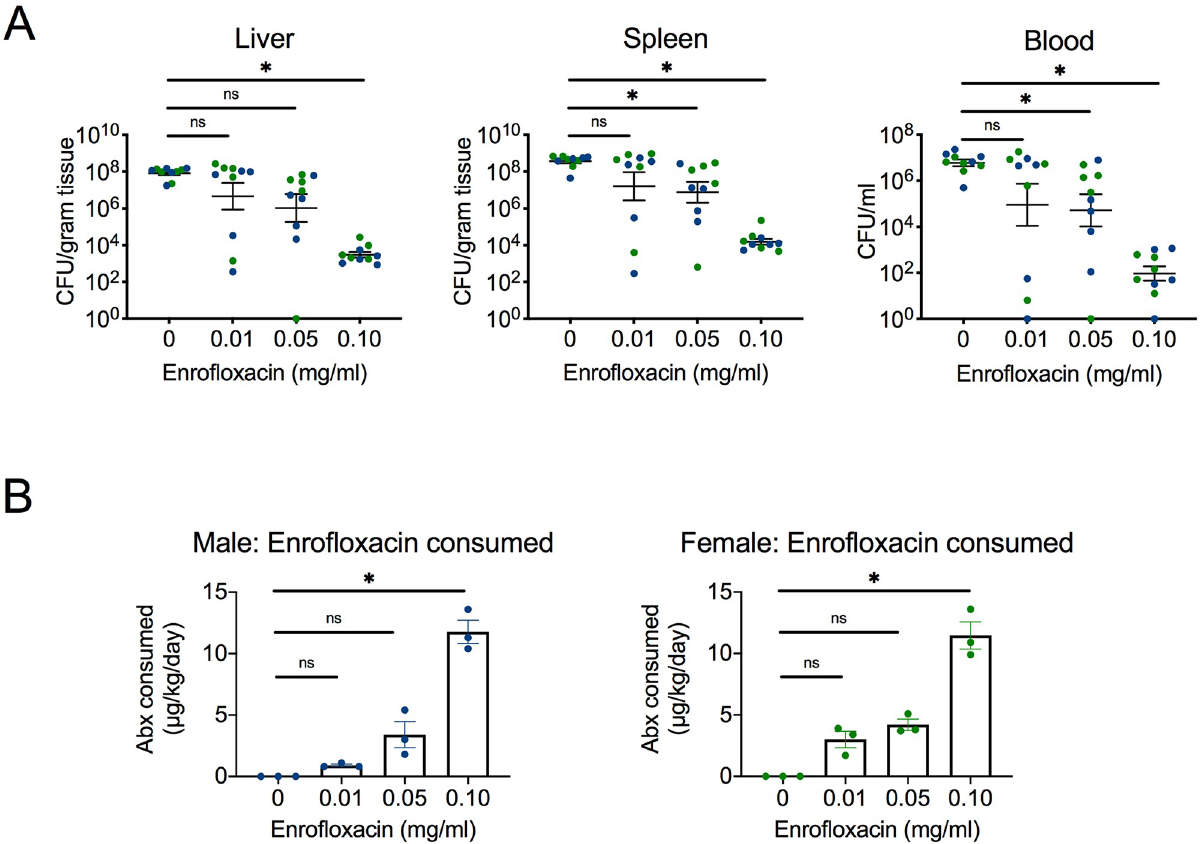
Fig 4. Antibiotic treatment failure occurs at specific concentrations in vivo . Enrofloxacin was administered directly into the drinking water on day 2 post-infection with multidrug-resistant S . Typhimurium D23580. Groups of C57BL/6J male (n = 5) and female (n = 5) mice on a standard diet were assessed for the following treatment groups: 0 mg/ml, 0.01 mg/ml, 0.05 mg/ml, and 0.10 mg/ml. Systemic bacterial burden was characterized by CFU in liver, spleen and blood collected at necropsy 5 days after infection ( A ). Water weights and mouse weights were collected daily. The average enrofloxacin consumed ( μ g/kg/day) was determined for each group based on water and mouse weights for days 2–3, 3–4 and 4–5 ( B ). Data are reported as mean ± SEM. Significance was determined on log-transformed values ( A ) or calculated values ( B ) with a Kruskal-Wallis test and Dunn’s multiple comparisons test ( � , p < 0.05; ns, not